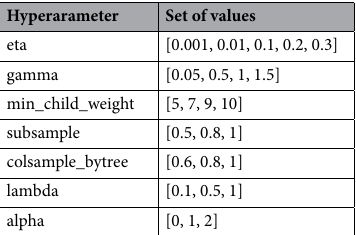
Table 1. Hyperparameter values used in the grid search for the tuning of the XGBoost